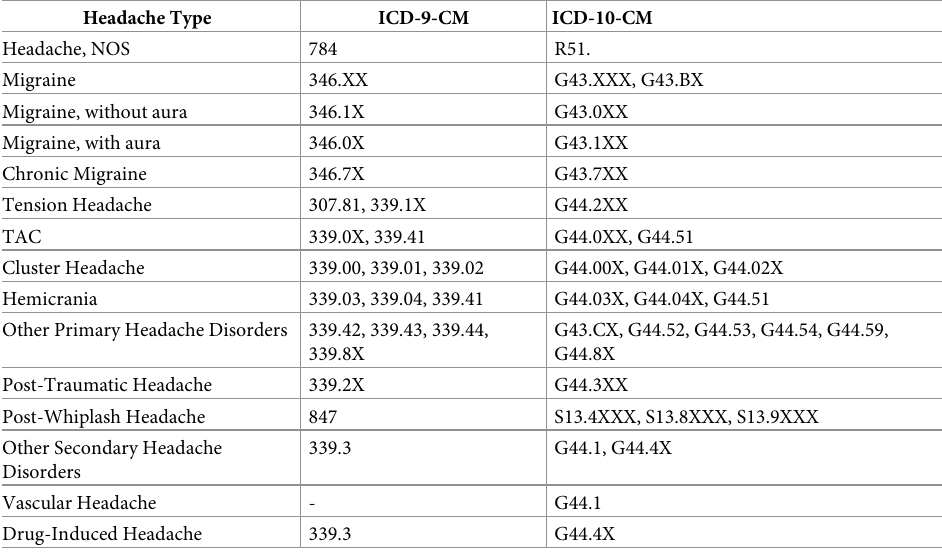
Table 1. ICD-9-CM/ICD-10-CM diagnostic codes for headache